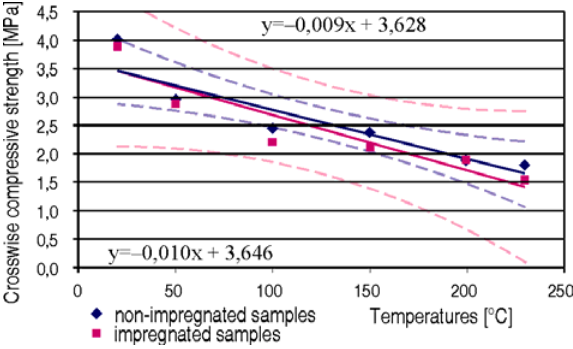
Fig 9. Crosswise compressive strength vs temperature for impregnated and non-impregnated wood